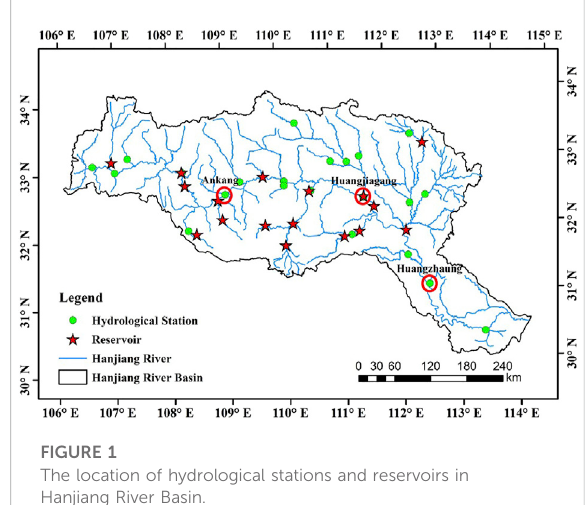
FIGURE 1 The location of hydrological stations and reservoirs in Hanjiang River